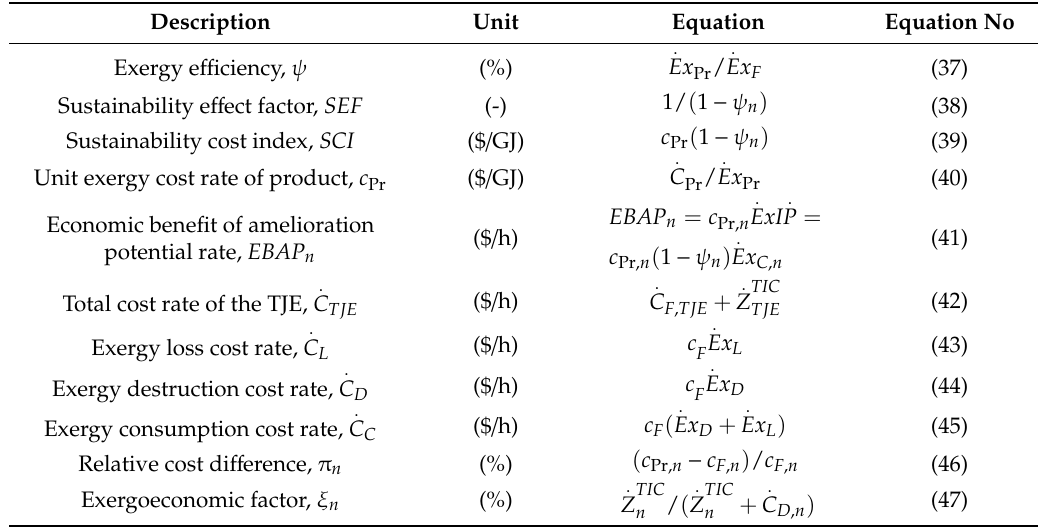
Table 5. Exergy, sustainability and exergoeconomic performance equations for the TJE.